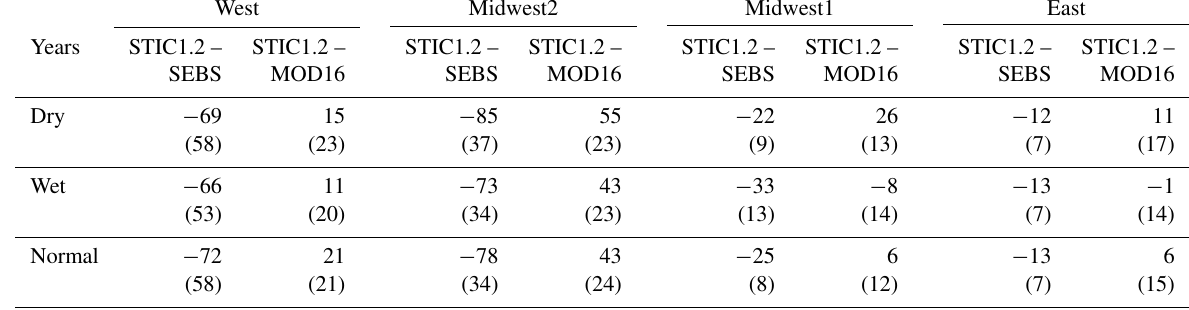
Table 5. Mean percentage difference in annual ET (standard deviation in parentheses) between STIC1.2 vs. SEBS and MOD16 from all pixels within the bounding box of four study zones during dry, wet, and normal years.